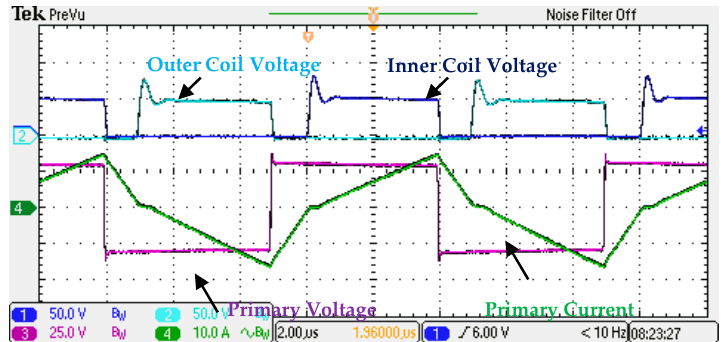
Figure 17. Current and voltage waveforms under the 6 A load current without ferrite core bars.